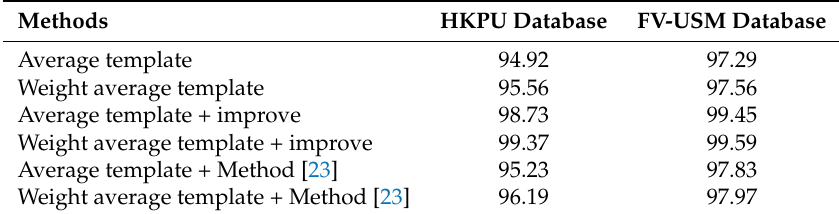
Table 4. Identification accuracy of various approaches on both